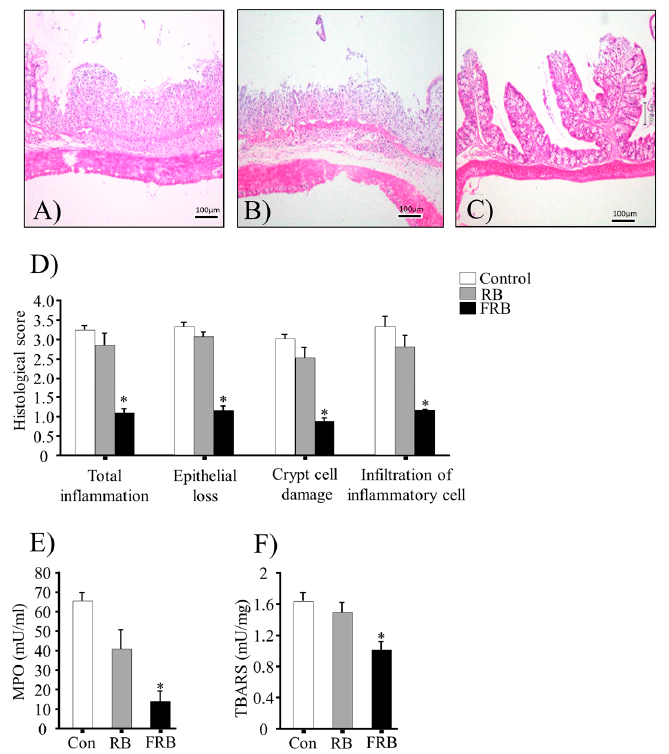
Figure 2. Dietary fermented rice bran (FRB) diet is associated with lower histopathology scores and inflammatory marker levels in dextran sodium sulfate (DSS)-induced colitis in the mouse model. Representative images (out of n = 4 in each group) of hematoxylin and eosin (H and E)-stained colonic tissues in ( A ) control; ( B ) rice bran (RB); and ( C ) FRB group animals; ( D ) histological scores. Histological scores were determined with following parameters: epithelial loss (0, none evident; 1, mild; 2, moderate; 3, severe; and 4, massive), crypt cell damage (0, none evident; 1, mild; 2, moderate; 3, severe; and 4, massive), and infiltration of the inflammatory cells in the mucosa (0, none evident; 1, mild; 2, moderate; 3, severe; and 4, massive). Scores were averaged to determine the total histological score in all parameters (five slides/sample); ( E ) Colonic myeloperoxidase (MPO) activity and ( F ) thiobarbituric acid-reactive substance (TBARS) values. The values are expressed as the mean ± SEM ( n = 4);